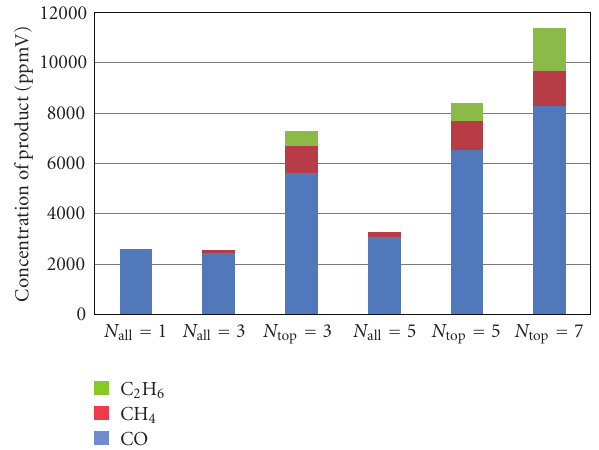
Figure 8: Comparison of product by CO 2 reforming after illumi- nation of Xe lamp with UV light of 72 hours for several Cr-doped TiO 2 film prepared under conditions of di ff erent N .